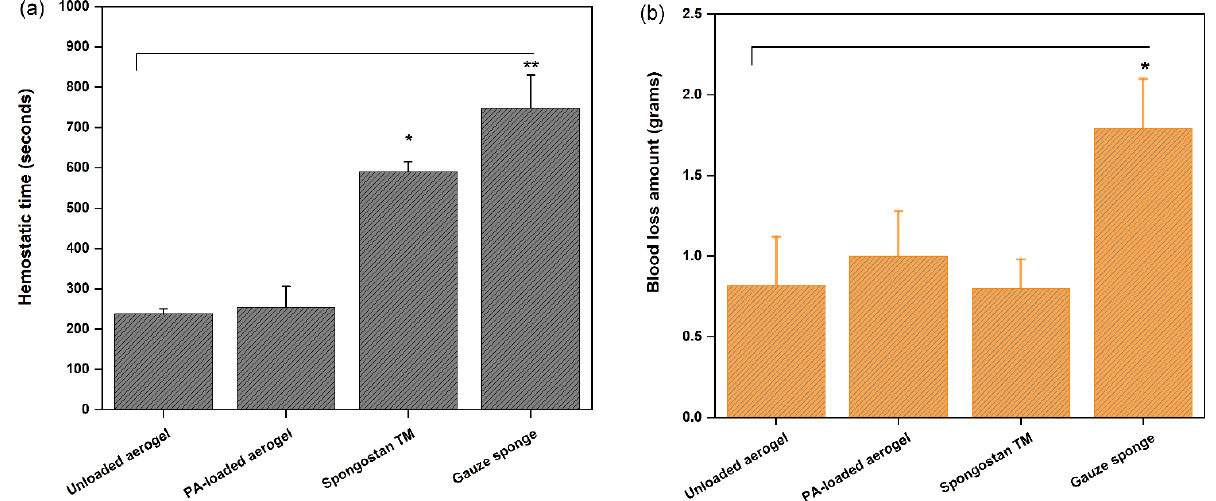
Figure 4. ( a ) Hemostatic times and ( b ) blood loss amounts, both measured during the in vivo assay for PA-loaded aerogel, unloaded aerogel, Spongostan TM and control gauze sponge. * p ≤ 0.05, ** p ≤ 0.01.